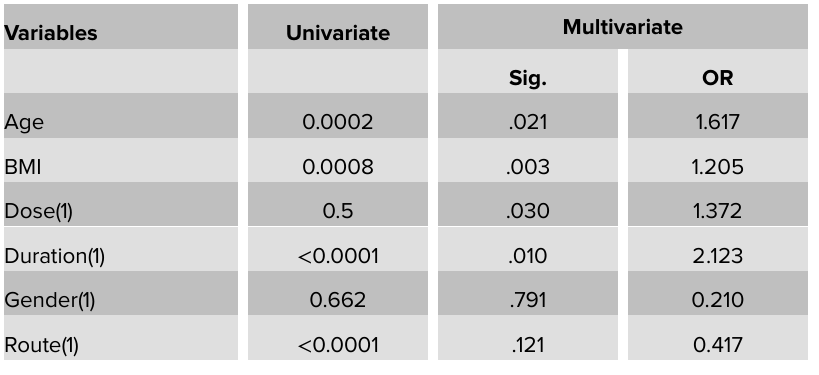
Table 6: Correlation of 6 independent variables with ceftriaxone liver insult using univariate and multivariate